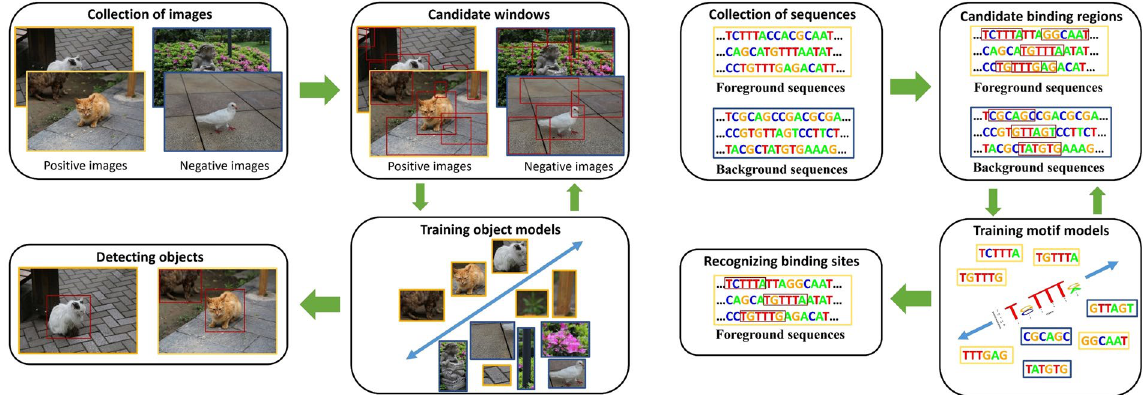
Figure 1. An overview of object detection and discriminative motif discovery. ( a ) Object detection. ( b ) Discriminative motif